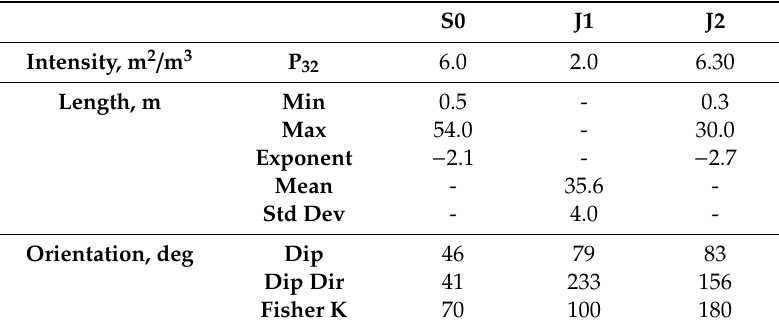
Table 3. Characteristics of discontinuity sets used to develop DFN 1.